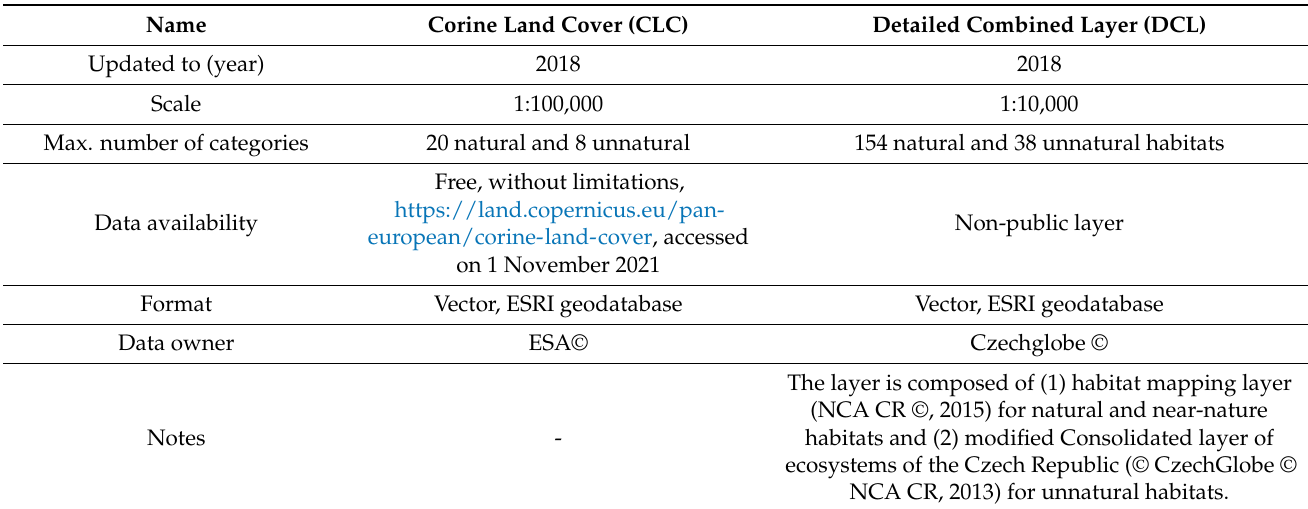
Table 2. Characteristics of GIS layers used to determine the actual land